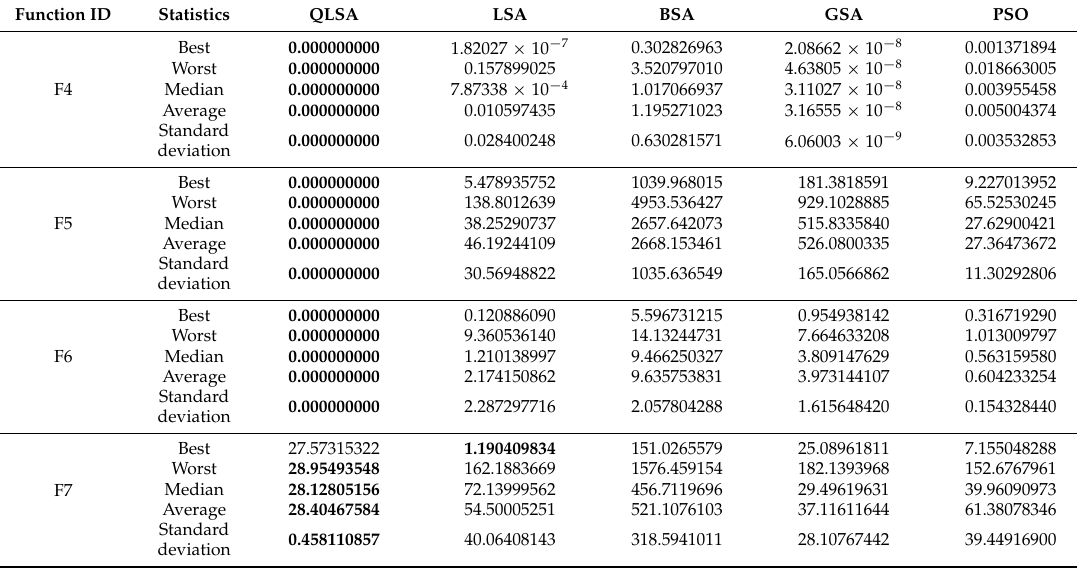
Table 6. Test 2 global optimization results for benchmark functions in Table